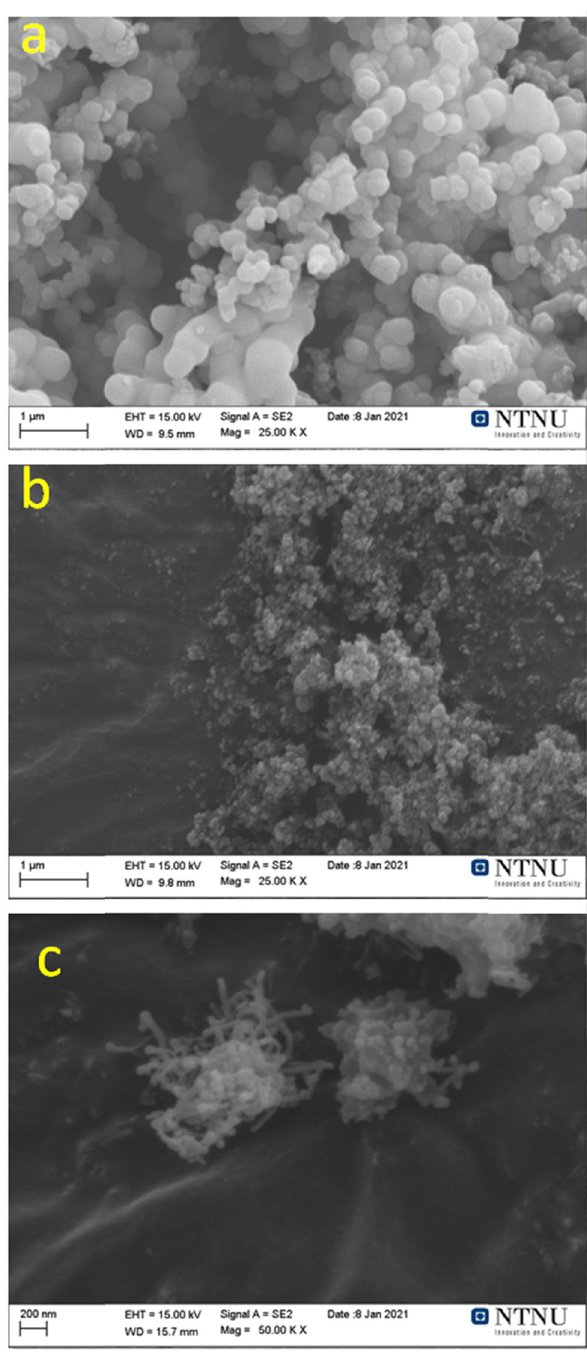
Figure 10: The SEM micrographs of the fume settled on the chamber wall: ( a ) He gas in the chamber, ( b ) Ar gas in the chamber, and ( c ) chamber vacuumed during the gas re fi ning process.